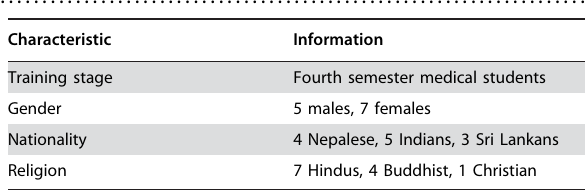
Table 1. Demographic characteristics of focus